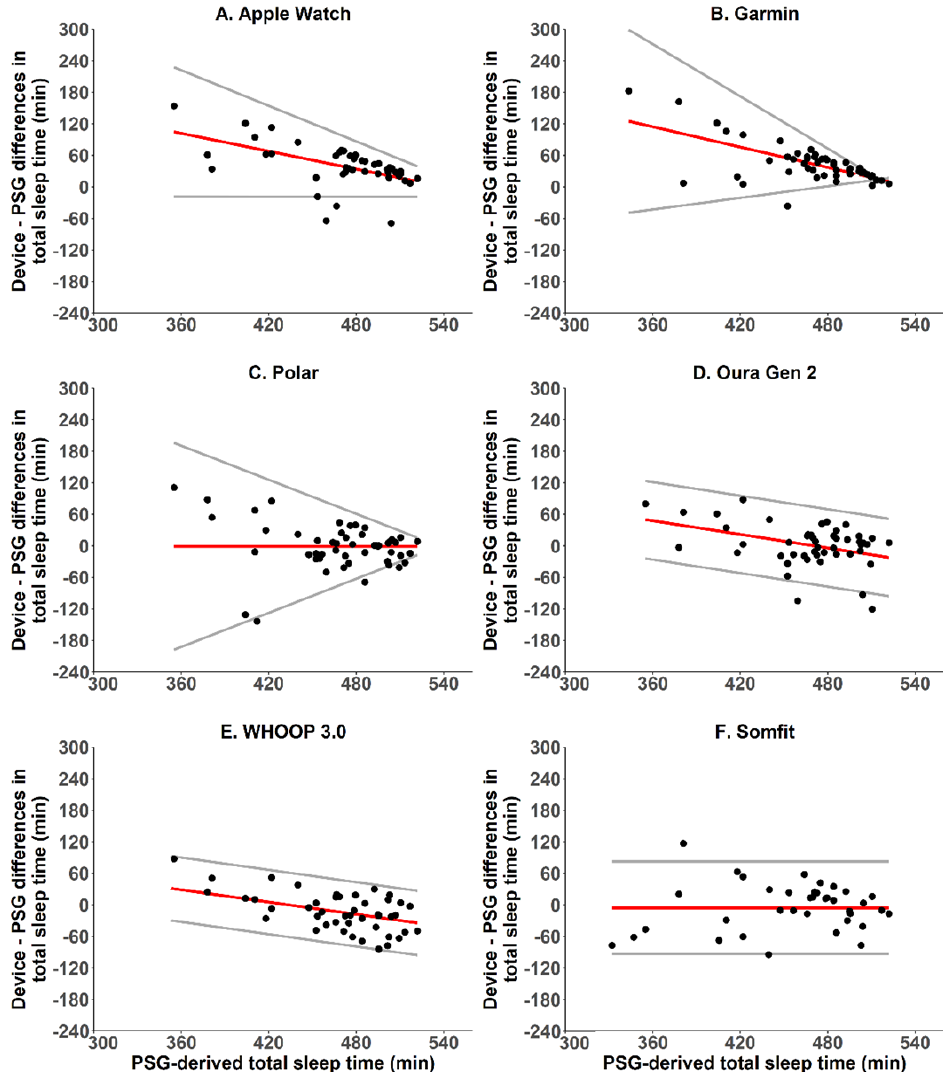
Figure 1. Bland – Altman plots for device – derived and PSG – derived measures of total sleep time. The y-axes represent the difference between the measures—positive values indicate devices overestimate relative to PSG, and negative values indicate devices underestimate relative to PSG. Solid red lines indicate the device bias relative to PSG. Solid grey lines indicate the 95% limits of agreement (±1.96 standard deviation).